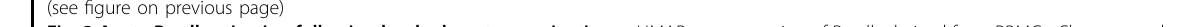
Fig. 3 Acute B cell activation following by the booster vaccination. a UMAP representation of B cells derived from PBMCs. Clusters are denoted by color and labeled with inferred cell types. b Dot plot of average expression and percentage of expressed cells of selected canonical markers in each labeled B cell subtype. c BCR clone differences across time points in each B cell subtype at D0, D3, and D14. d The relative percentage of each isotype in each B cell subtype at D0, D3, and D14. e Dot plot shows the cell cycle score and average expression of cell cycle markers, TOP2A, MCM6 and MKI67 , in plasma cells. Dot size depicts the percentage of the indicated gene-expressing cells. f The enriched GO-BP terms of upregulated genes in plasma cells in PrSV group at D3 (left) or D14 (right) post-vaccination. P value was derived by Benjamini & Hochberg